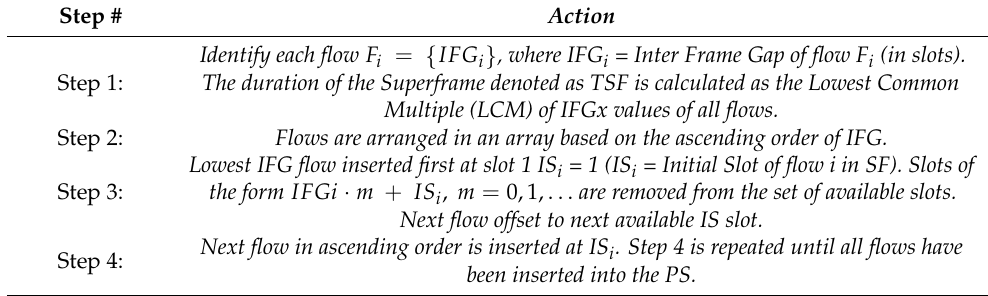
Table 1. The CEXP-Fit